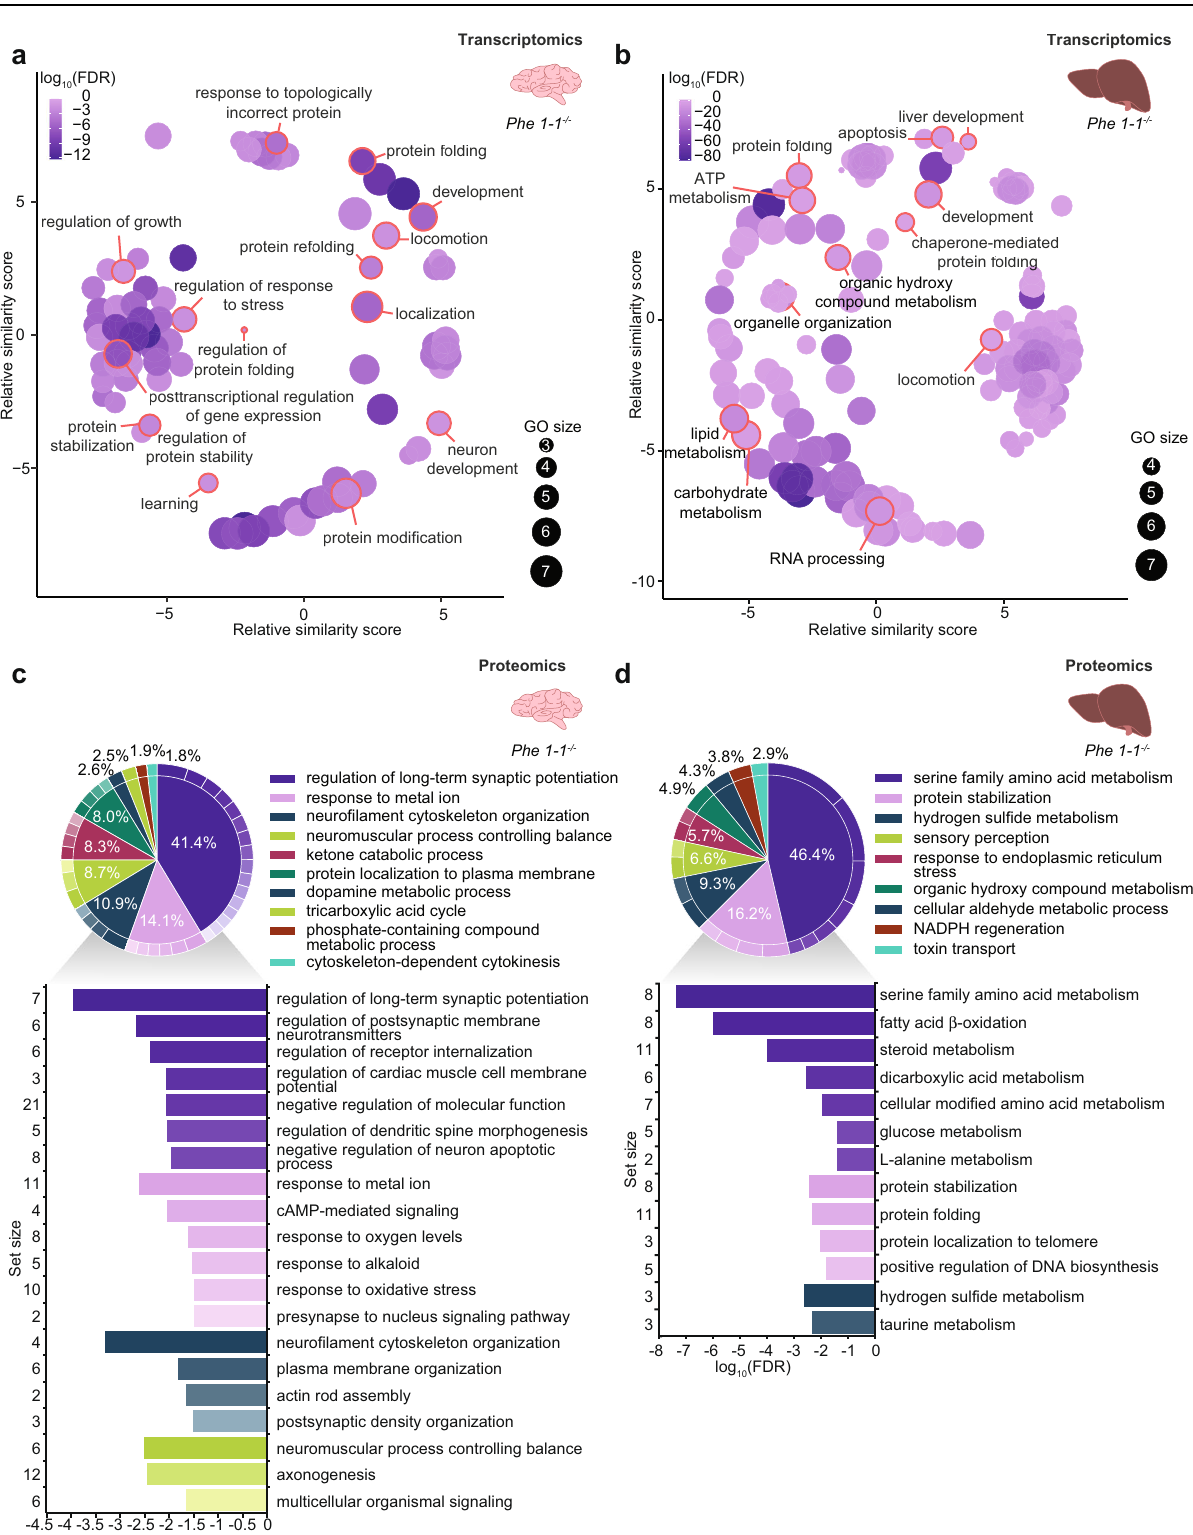
brain structure. Neurological changes occurred only at a cellular level, as suggested by the proteomic and transcriptomic data. Immunos- taining revealed a decrease in calbindin-positive Purkinje cells throughout the cerebellum, which was most signi fi cant in speci fi c lobules of the cerebellar hemispheres in tRNA-Phe-1-1 -/- compared to the control mice (Fig. 4e and Supplementary Fig.